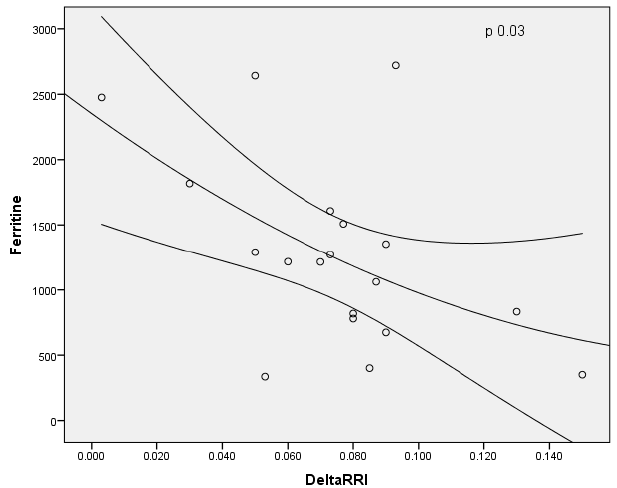
Figure 5. Delta RRI in male and female patients. Box plot showing the differences of Delta RRI be- tween male and female subsamples. Comparison with Student ’ s t -test for independent samples showed that males had higher Delta RRI values than females.